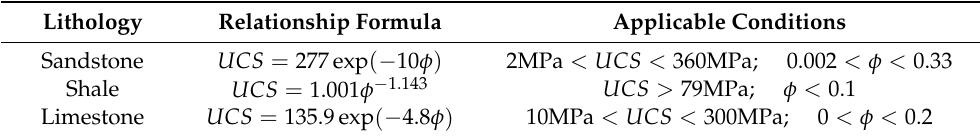
Table 1. Relations between UCS and porosity in different rocks.